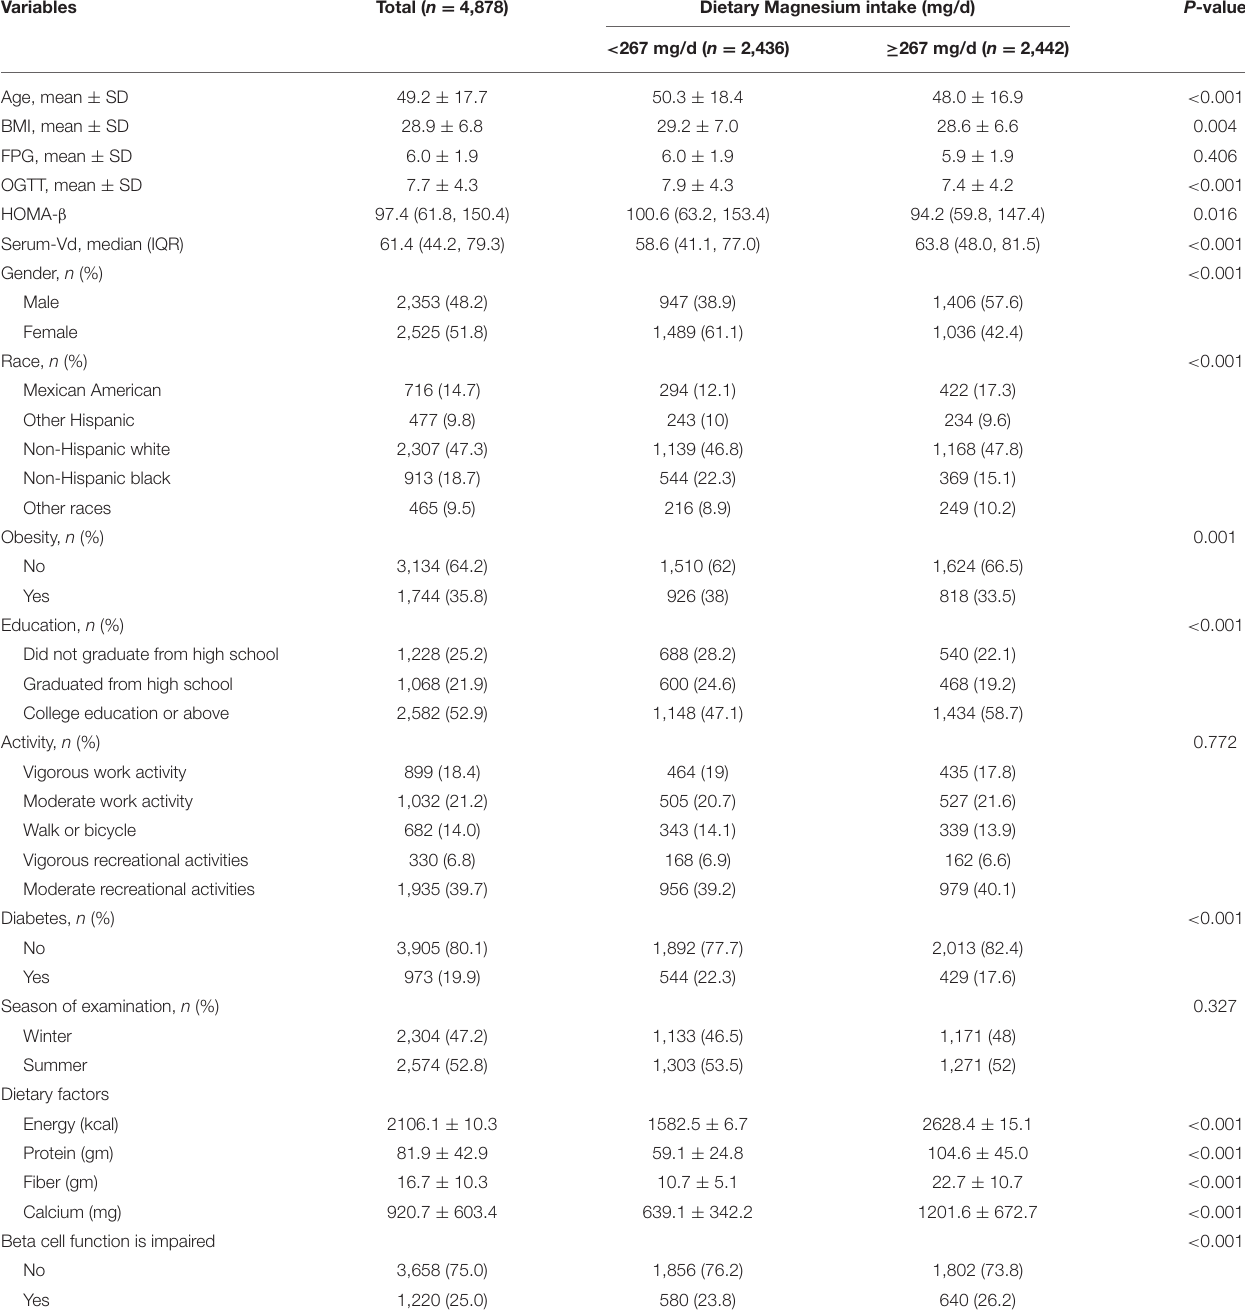
TABLE 1 | Basic information description of